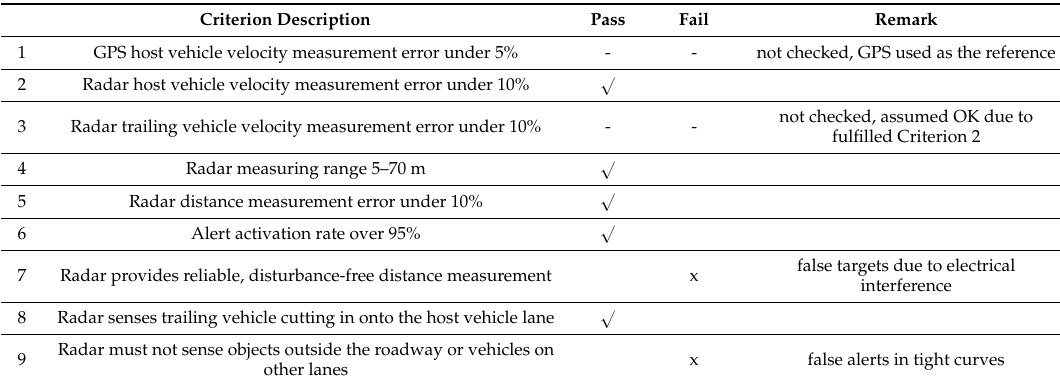
Table 4. Summary of Pass/Fail criteria and their